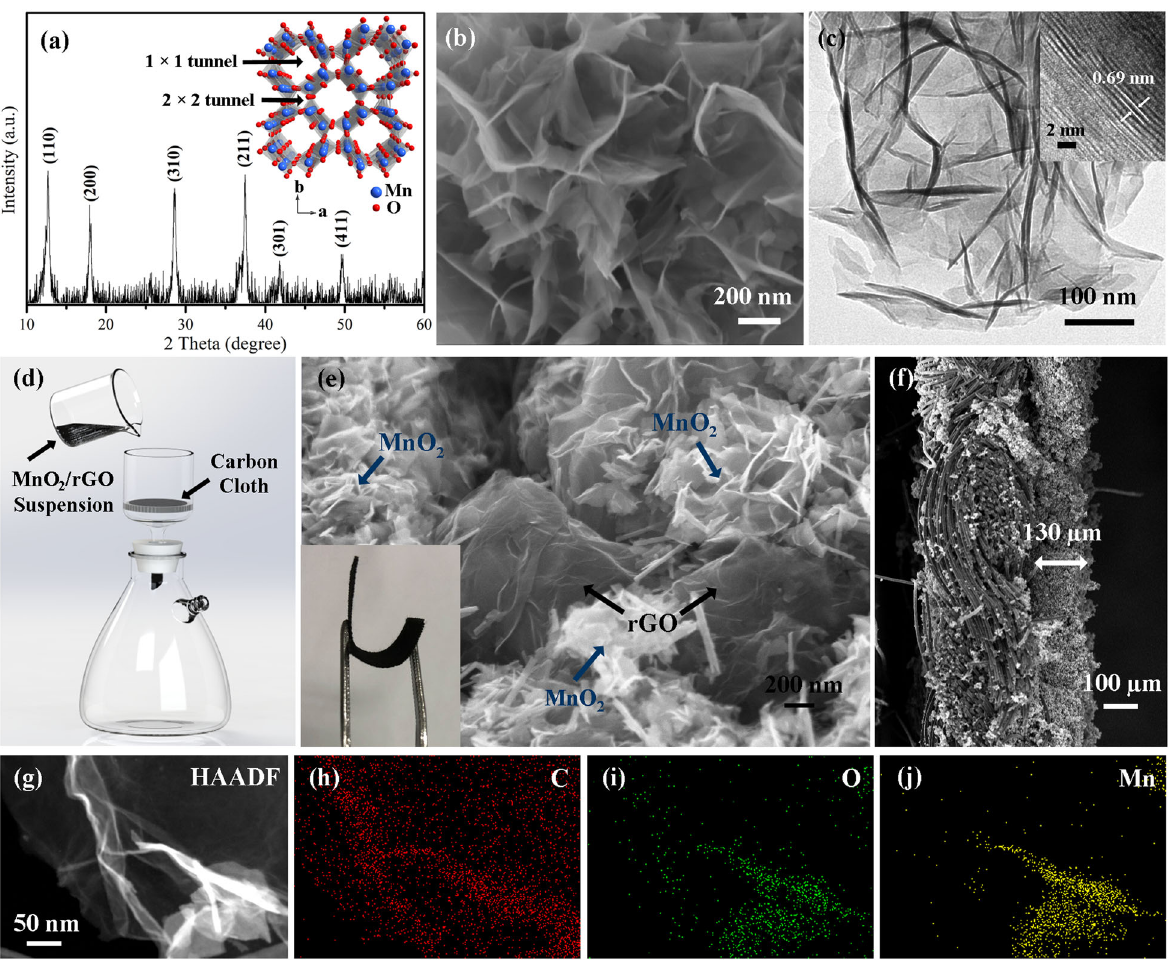
Fig. 2 Preparation and morphology of MnO 2 /rGO sample. a XRD spectrum of MnO 2 sample. Inset in a : crystallographic structure of α -MnO 2 . b SEM image taken from the MnO 2 sample. c TEM image taken from the MnO 2 sample. Inset in c : high resolution TEM image of MnO 2 nanosheets. d Schematic diagram of the vacuum fi ltration on carbon cloth for preparing MnO 2 /rGO electrodes. e SEM image and the photographs (the inset) of the MnO 2 /rGO sample on carbon cloth. f The cross-sectional SEM image of MnO 2 /rGO on carbon cloth. g High angle annular dark fi eld (HAADF) image taken from part of the MnO 2 /rGO sample. h – j EDX elemental maps taken from the same region shown in